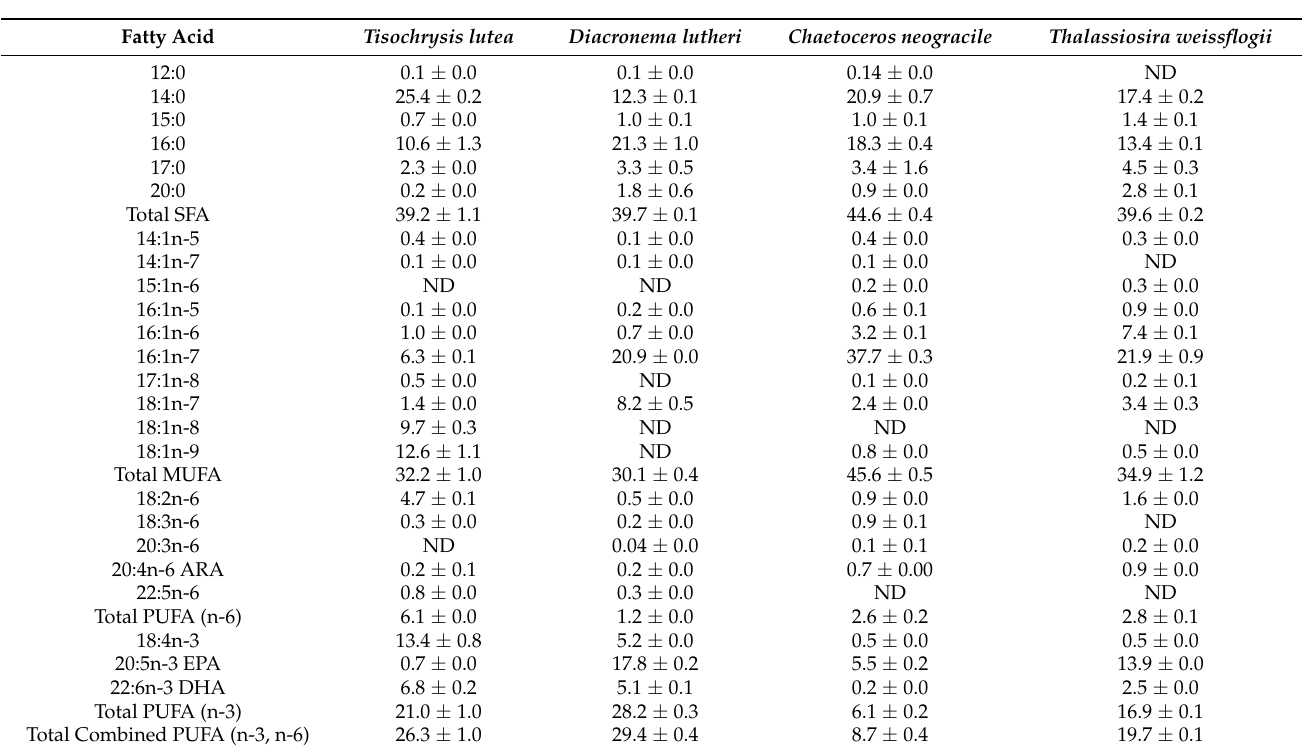
Table 2. Fatty acid profile (as a percentage of total fatty acid) of microalgae species used to feed post-set sunray venus clams ( Macrocallista nimbosa ). ND: not detected. Data are presented as the means ± SD ( n =